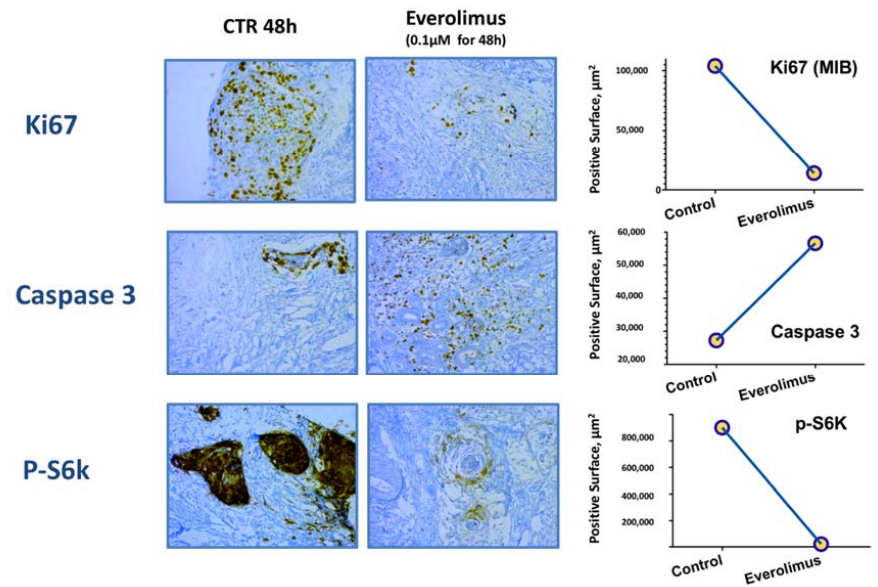
Figure 4. Ex vivo study on fresh pre-treatment tumor tissue: Ki67, caspase 3, and p-S6K immunohistochemistry before and after 48 hours exposure with 0.1 μ M of everolimus or with dimethylsulphoxide for controls (CTR). Y-axis scale showing positive staining surface in µ m 2 versus total histological slide surface.